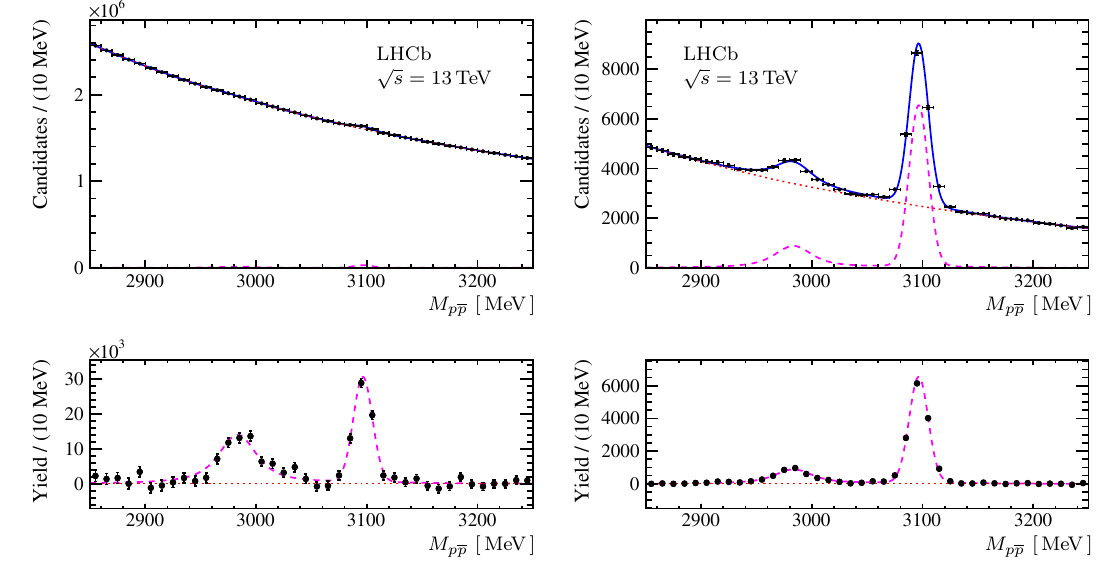
Fig. 1 Invariant-mass distribution of the pp candidates for (top left) prompt-enrichedand(topright) b -hadron-enrichedsamplesintheentire p T range, 6 . 5 < p T < 14 . 0GeV. The solid blue lines represent the total fit result. The dashed magenta and dotted red lines show the sig-